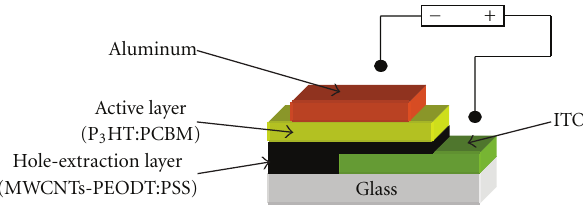
Figure 1: Schematic device structure for organic solar cells doped with